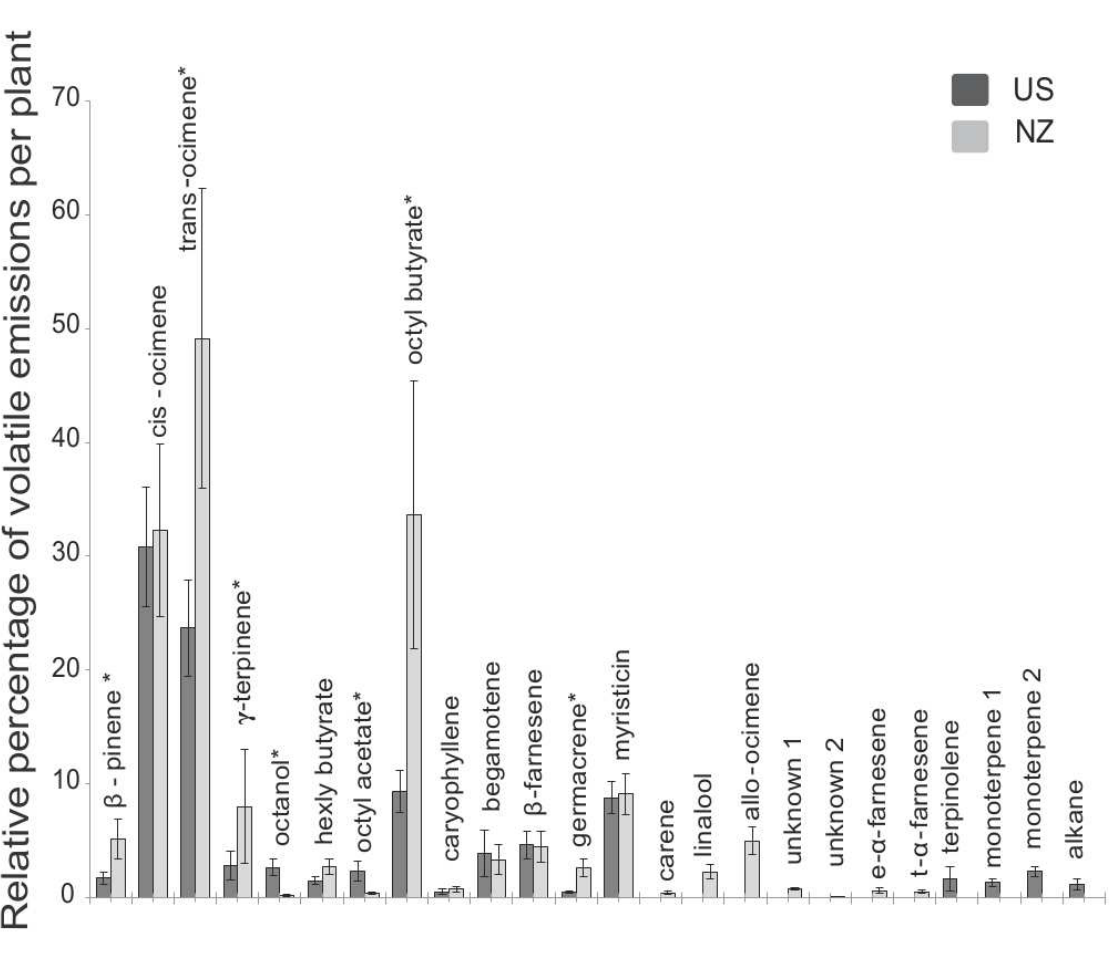
F IGURE 1. A comparison of the composition of volatile emitted from US and NZ flowers. Error bars represent standard error. Significa differences (MANOVA) indicated by